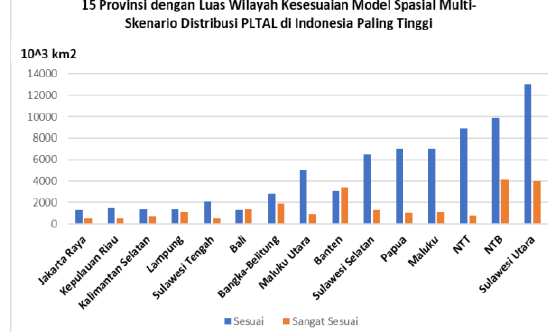
Figure 7 Area of conformity of multi scenario spatial model of PLTAL distribution in Indonesia is highest